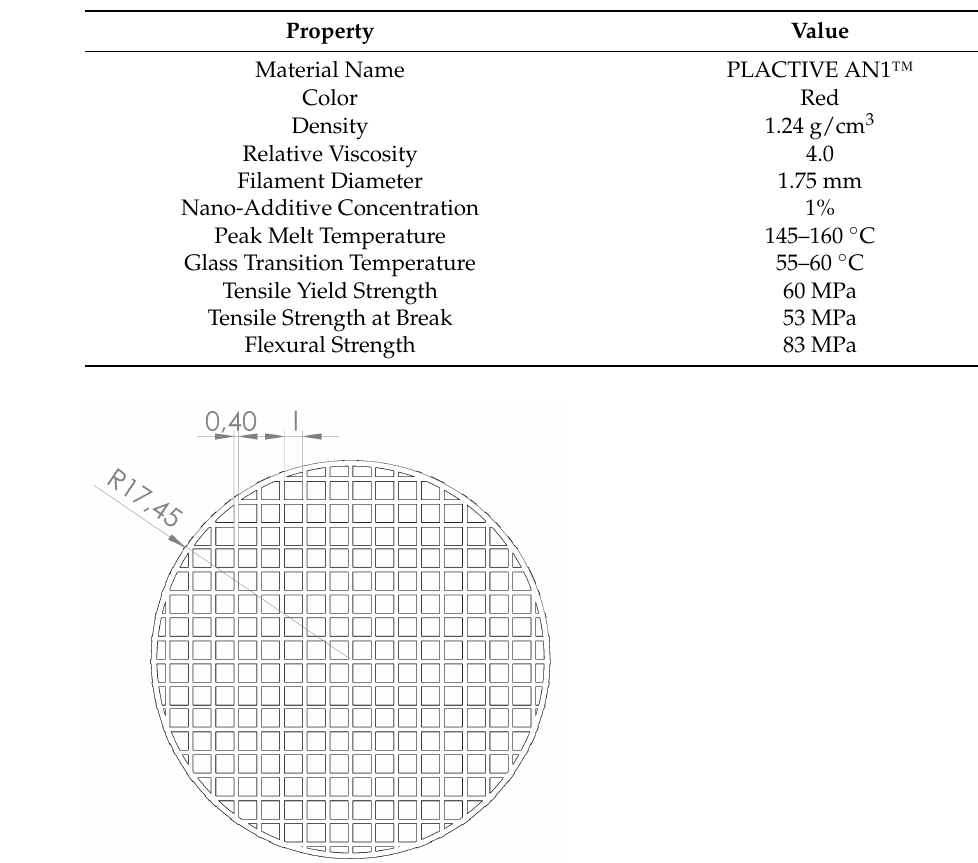
Figure 1. Scheme of the 3D-printed PLACTIVE™-based grids.